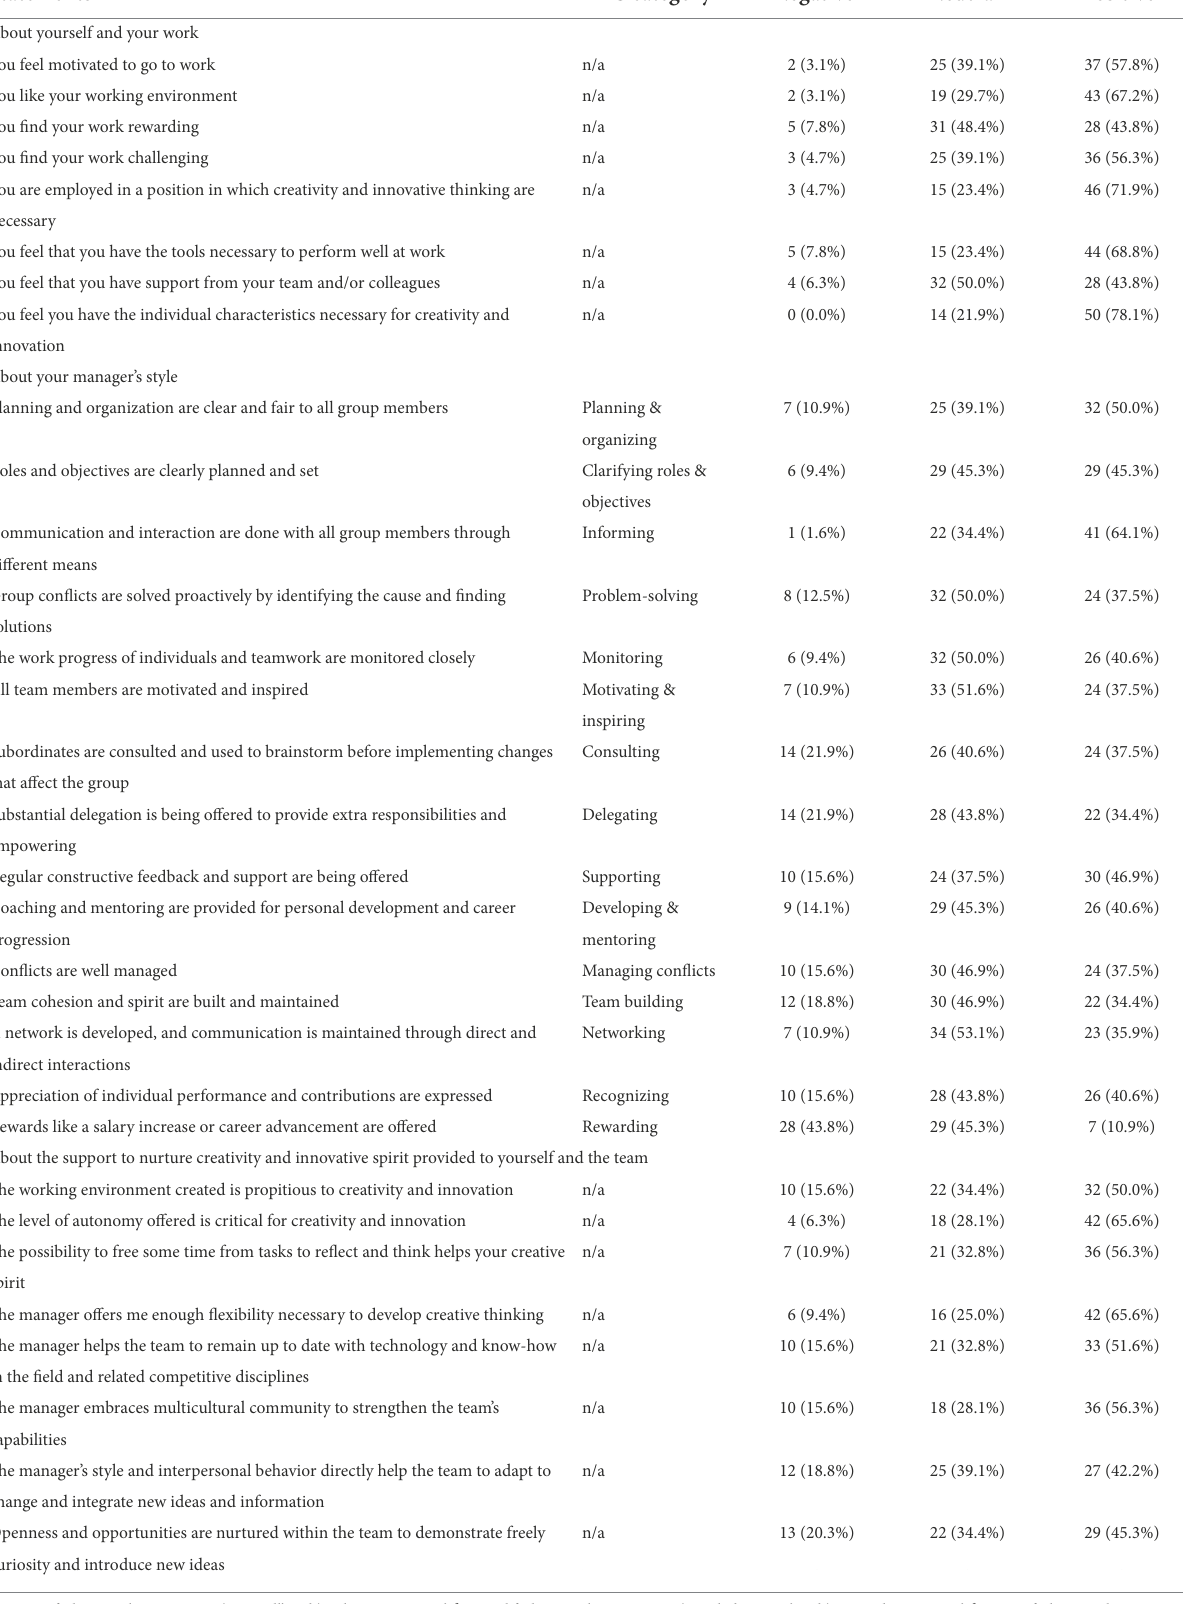
TABLE 2 Categories of an individual’s feelings and perspectives about